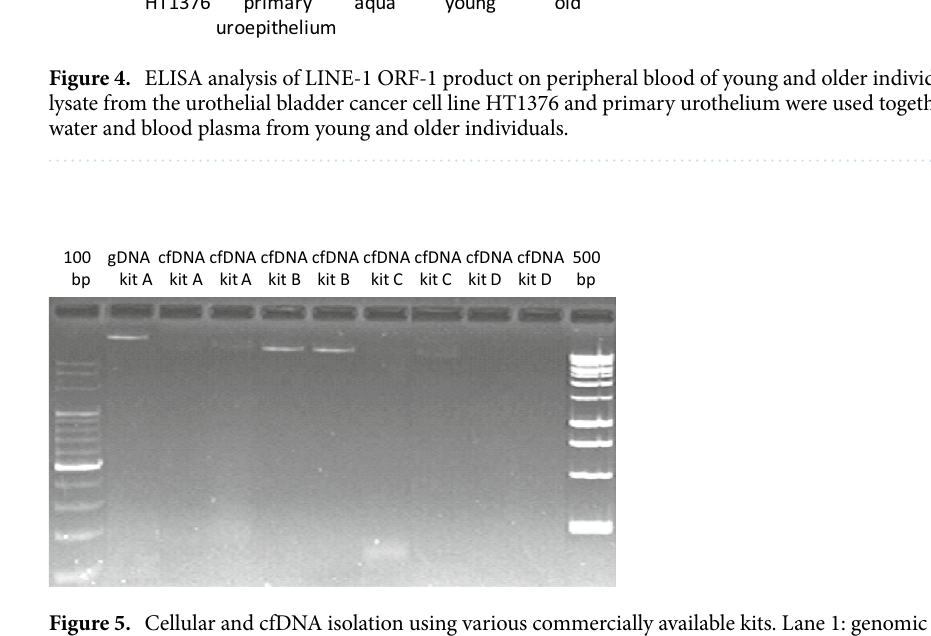
Figure 5. Cellular and cfDNA isolation using various commercially available kits. Lane 1: genomic DNA by QiAamp DNA Blood Mini Kit (kit A ). Lane 2/3: cfDNA by QiAamp DNA Blood Mini Kit (kit A). Lane 4/5: cfDNA by PME free-circulating DNA Extraction Kit (kit B ). Lane 6/7: cfDNA by Quick-cfDNA Serum & Plasma Kit (kit C ). Lane 8/9: cfDNA by QIAamp MinElute ccfDNA Kit (kit D